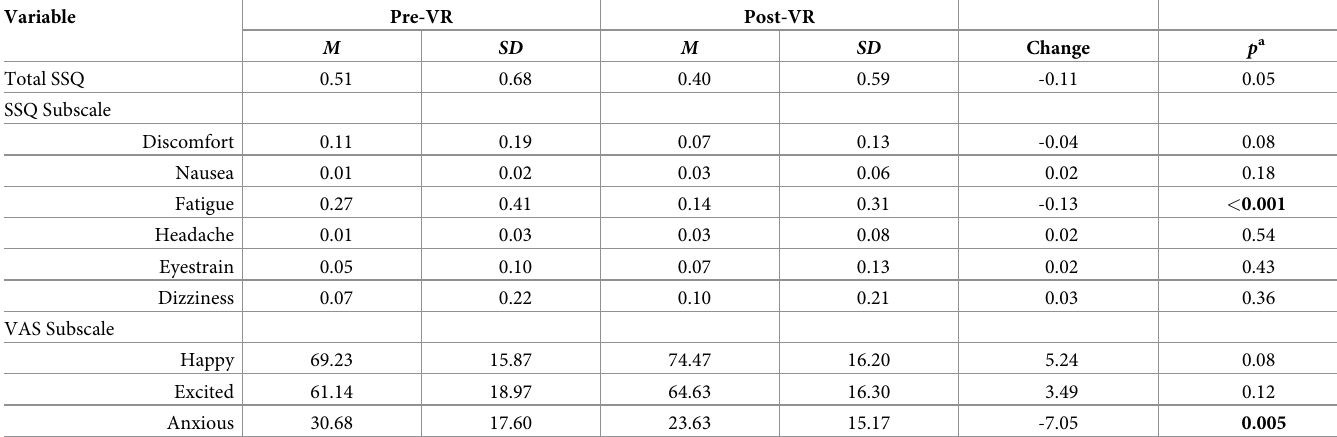
M = Mean; SD = Standard deviation; SSQ = Simulator Sickness Questionnaire; VAS = Visual Analogue Scale. a Significance values derived from paired t -tests. Bolded p -values are significant at p <